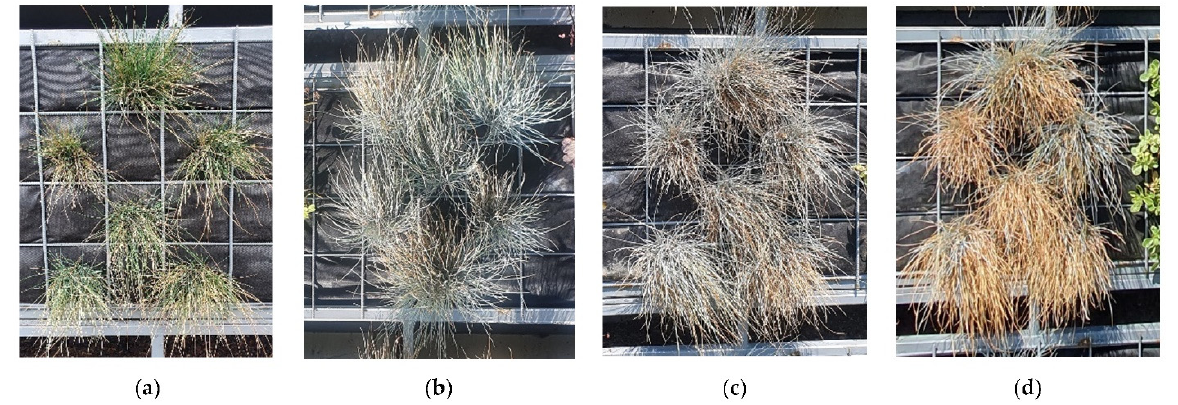
Figure 10. Festuca glauca March–August 2020, level 2 southern facade: ( a ) 3 March 2020; ( b ) 19 June